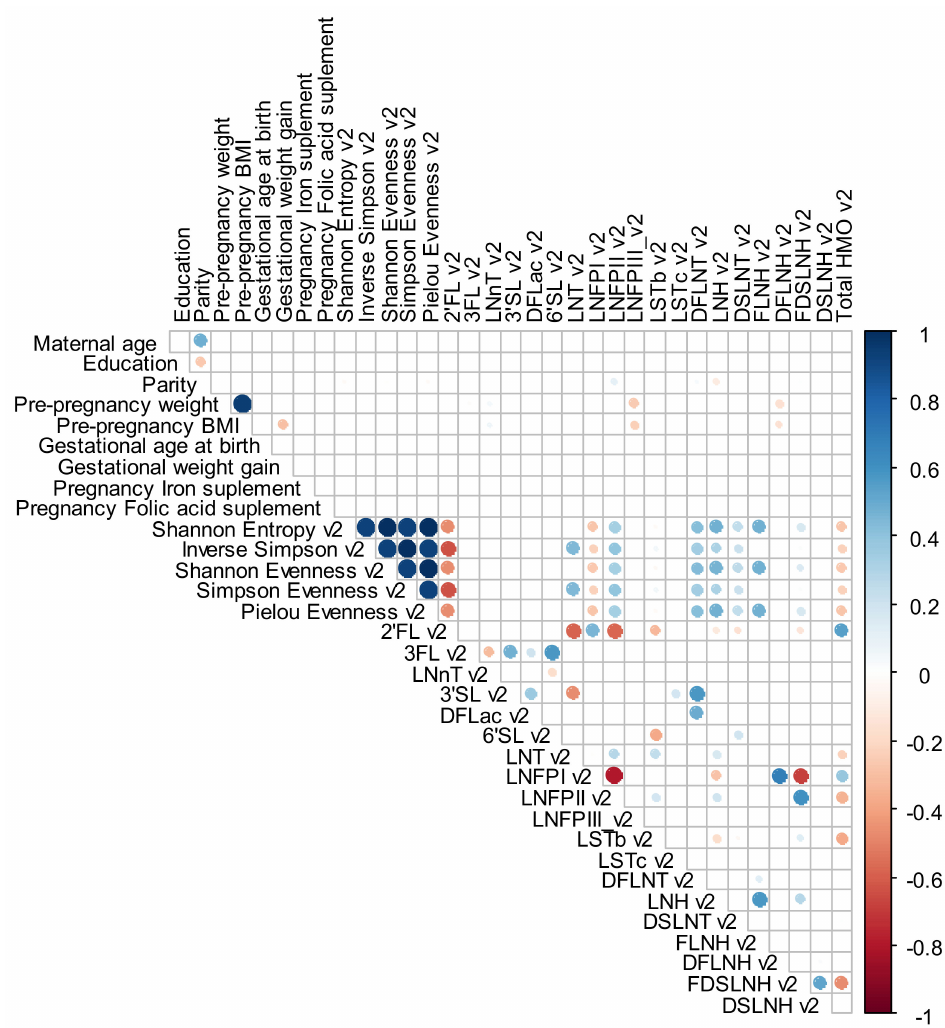
Figure 5. Spearman rank correlations between maternal demographic, anthropometric, reproductive and supplementary variables and individual HMO concentration in mmol / L and diversity and evenness at 28–50 days. The circle only becomes visible for the correlations that present a level of significance ≤ 0.01. The blue color indicates a positive and the red color a negative correlation. BMI: body mass index; DFLac, difucosyllactose; DFLNH, difucosyllacto-N-hexaose; DFLNT, difucosyllacto-N-tetrose; DSLNH, disialyllacto-N-hexaose; DSLNT, disialyllacto-N-tetraose; FDSLNH, fucodisialyllacto-N-hexaose; FLNH, fucosyllacto-N-hexaose; HMO, human milk oligosaccharide; LNFP, lacto-N-fucopentaose; LNH, lacto-N-hexaose; LNnT, lacto-N-neotetraose; LNT, lacto-N-tetrose; LSTb, sialyl-lacto-N-tetraose b; LSTc, sialyl-lacto-N-tetraose c; 2 (cid:48) FL, 2 (cid:48) -fucosyllactose; 3FL, 3-fucosyllactose; 3 (cid:48) SL, 3 (cid:48) -sialyllactose; 6 (cid:48) SL, 6 (cid:48)